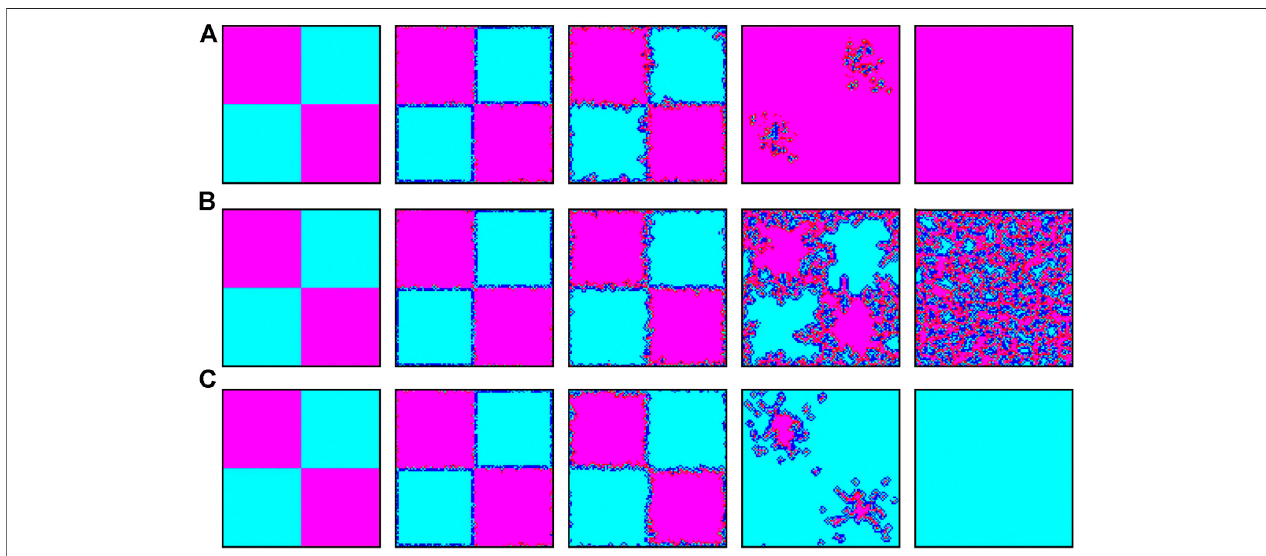
FIGURE 4 | Initial evolution of the prepared scenario. The top, medium and bottom correspond to r values of 0.1, 0.3, 0.6 respectively. From left to right, the snapshotscorrespondtoMCS (cid:1) 0,1,10,100,and50,000.Cooperator(C),cooperativerewarder(CR),defector(D)anddefectiverewarder(DR)areshownincolorcyan, blue, magenta, and red respectively.